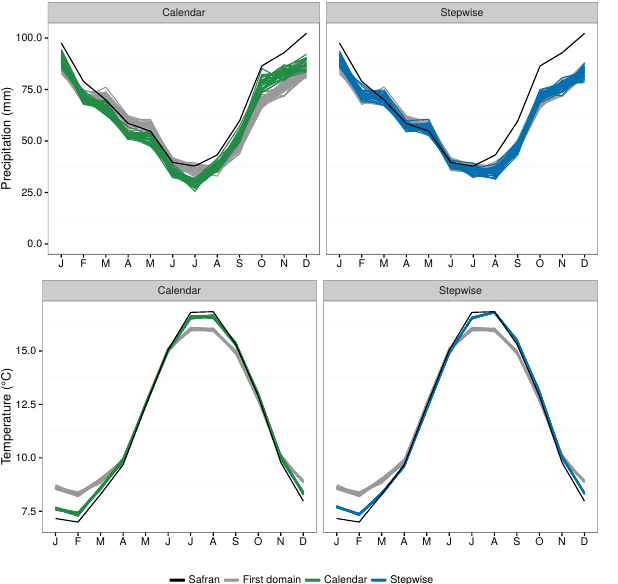
Figure 4. Precipitation and temperature interannual regimes be- tween 1959 and 2007 for the Finistère case study zone from Safran and the three subselection methods, through their 25 individual re- alizations.